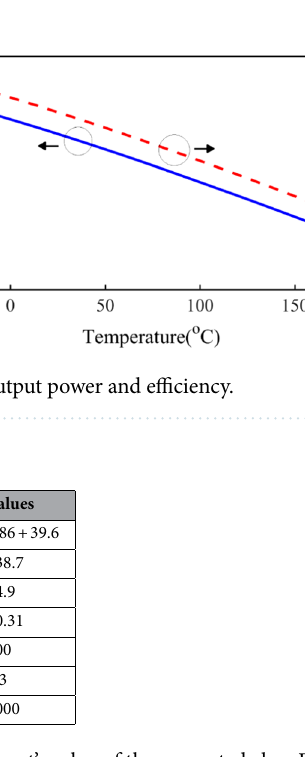
Table 2. The element’s value of the presented class E inverter at 25 °C.